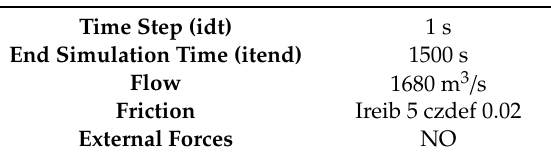
Table 2. SHYFEM Table 2. SHYFEM setups.